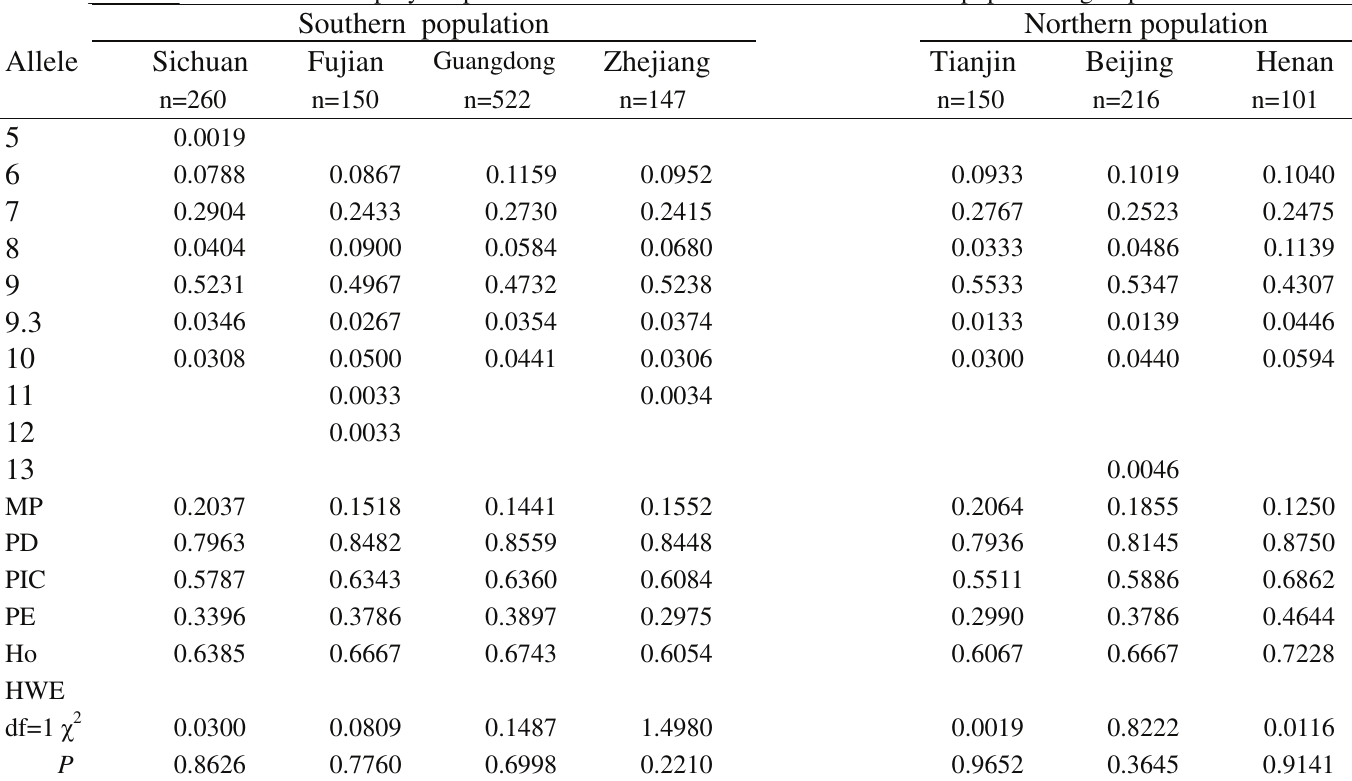
Table S4- Genetic polymorphism at the TH01 locus for the seven Chinese population